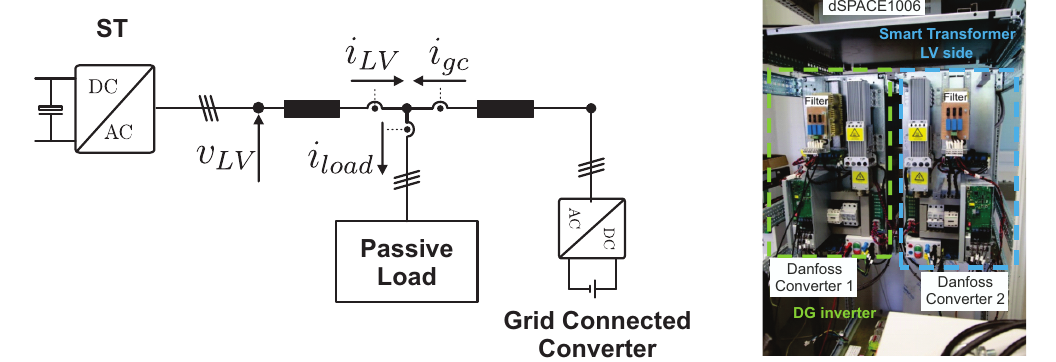
Figure 8. Lab experimental setup scheme and